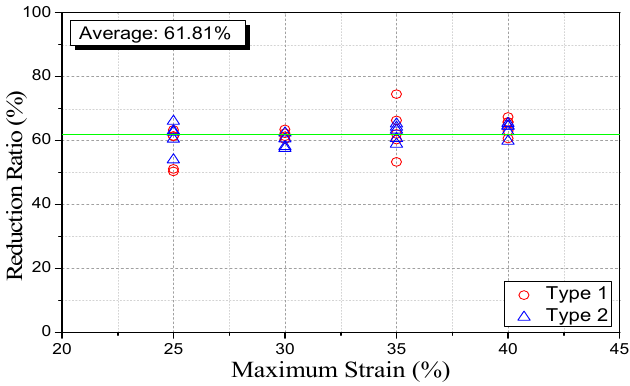
Figure 15. Energy dissipation reduction ratio of all Types.